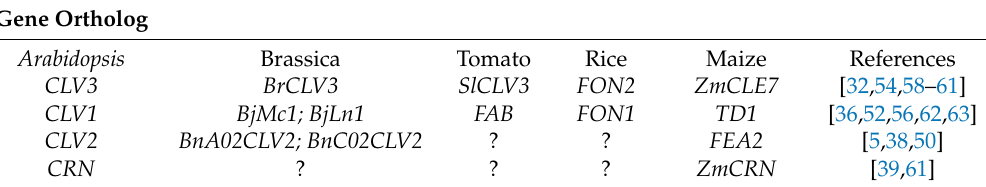
Table 1. CLV peptide and receptor gene orthologs in crop